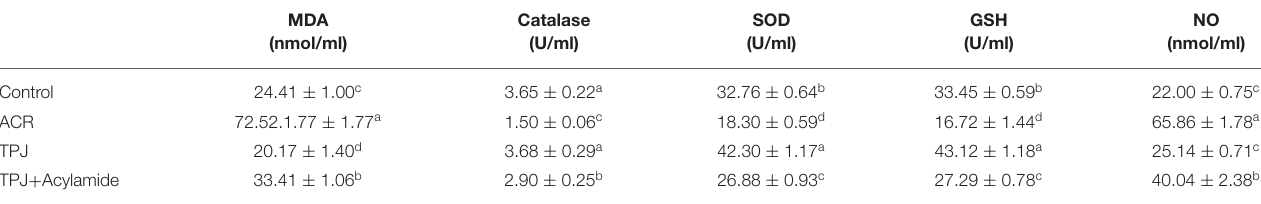
Values are expressed as means ± SE. Means in the same column with different superscript indicate significant statistical differences at p <